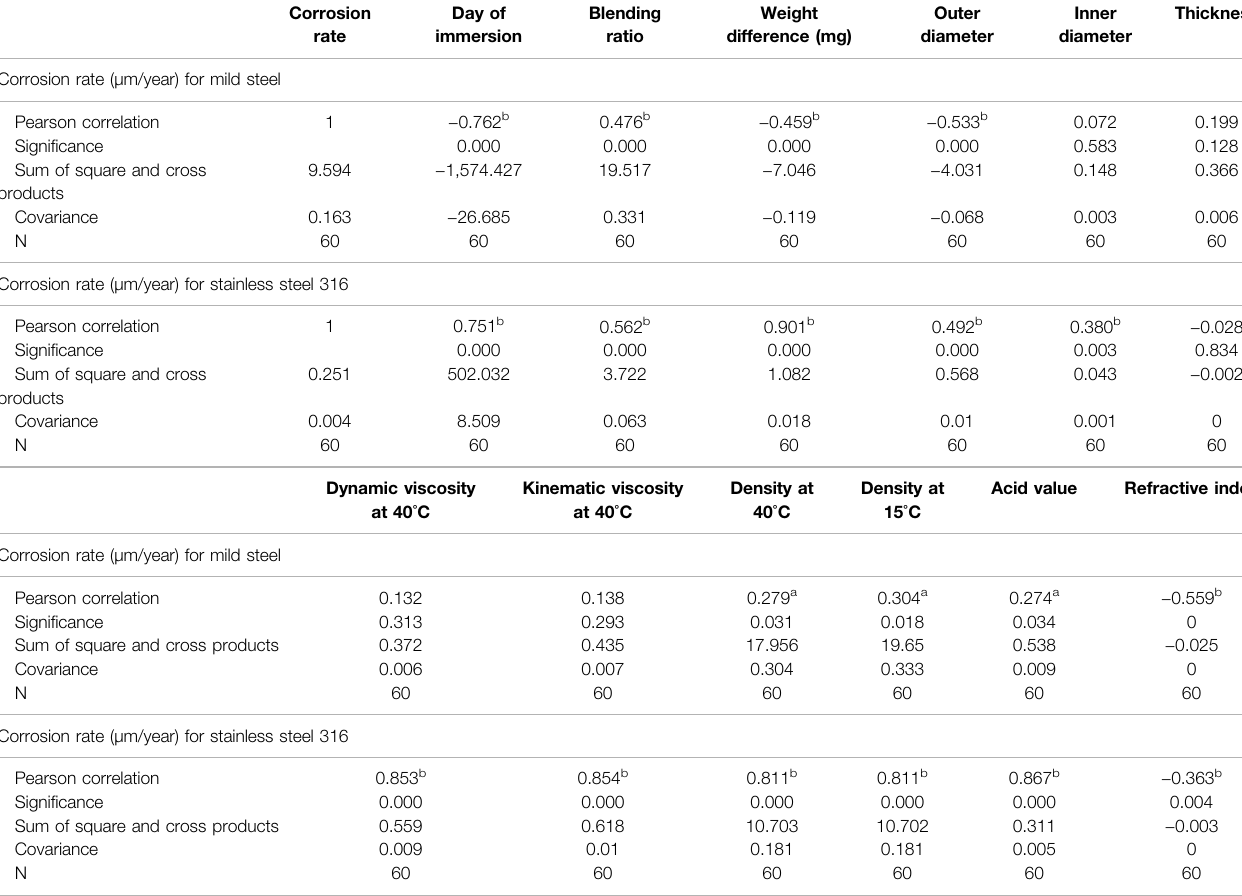
TABLE 7 | Pearson correlation and covariance between corrosion rate with variables.